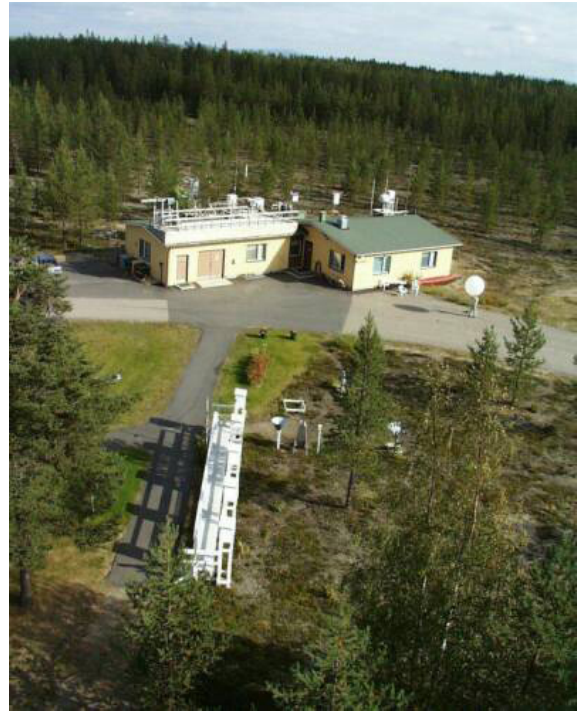
Figure 1. View of Sodankylä observatory. The Brewer is located on the roof in the enclosure on the left.